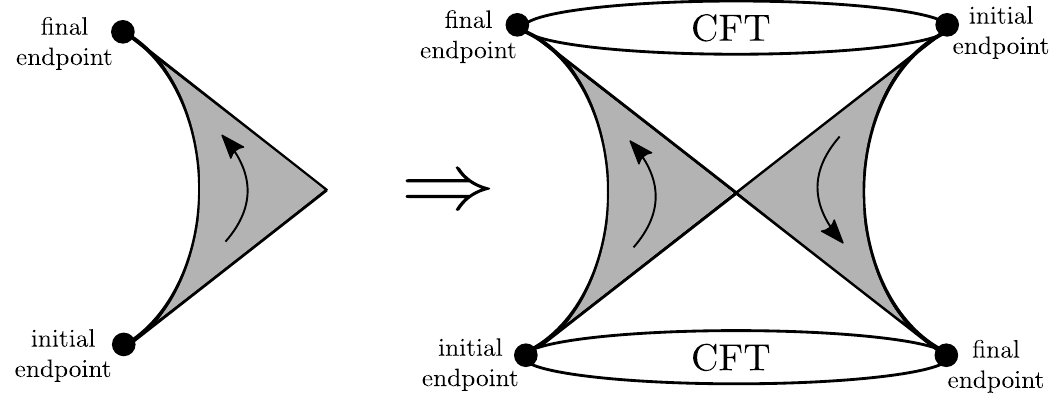
Figure 2 . Starting from a causal patch, one can introduce the rest of de Sitter space, including its conformal boundary, via the doubled phase space formalism. First, we construct two antipodally- related copies of the causal patch, with opposite intrinsic time orientations. Next, we evolve the fields out of the doubled causal patch into the rest of de Sitter